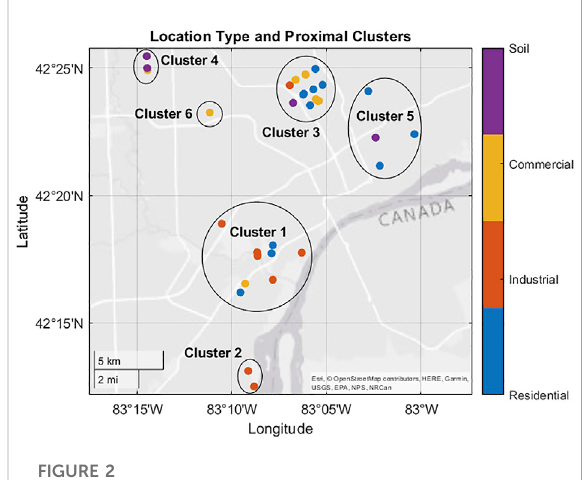
FIGURE 2 Clusters identi fi ed by k-means clustering and classi fi ed by location type (Identi fi ed by tax zoning